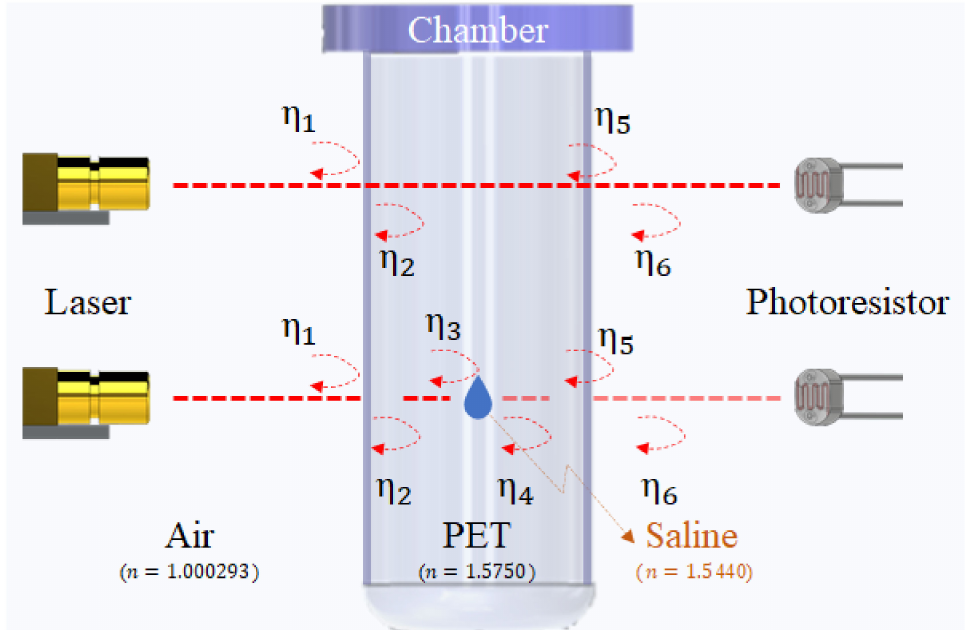
Figure 5. Comparative experiment conducted to quantify the loss rates with and without saline in the chamber. Table 1. Comparative experimental results of refractory value and loss rate pertaining to without saline and with saline cases.